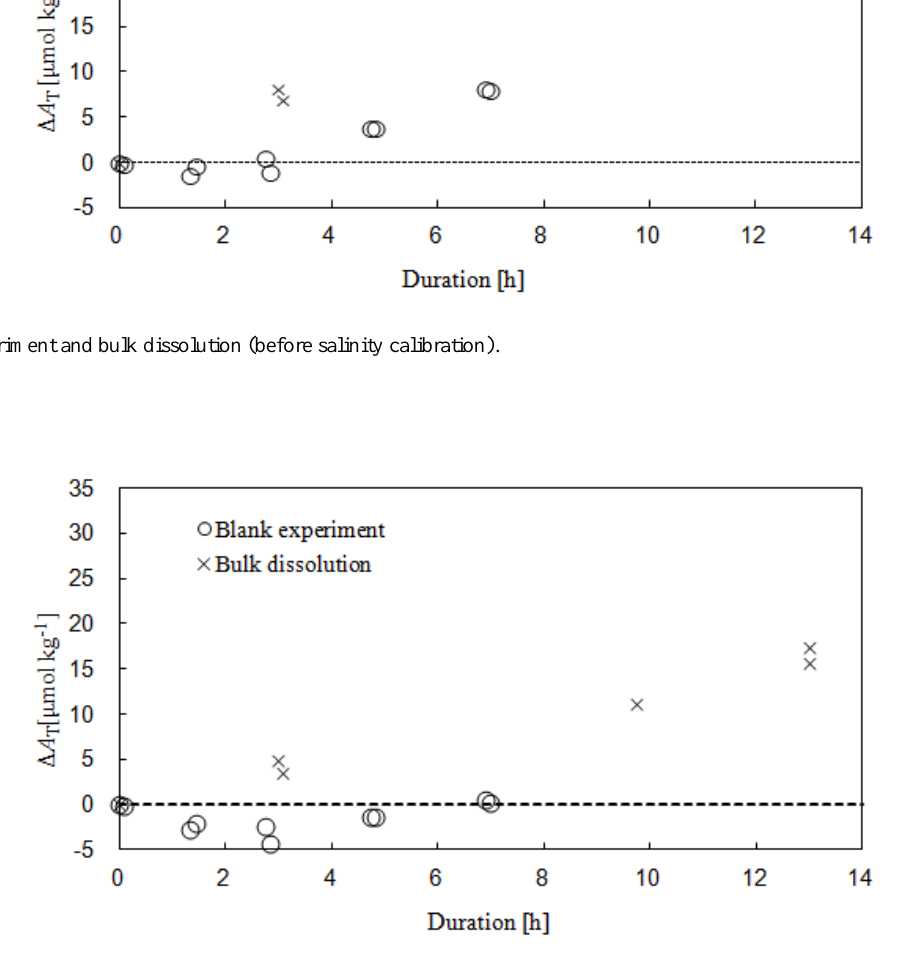
Fig. 4. Blank experiment and bulk dissolution (after salinity